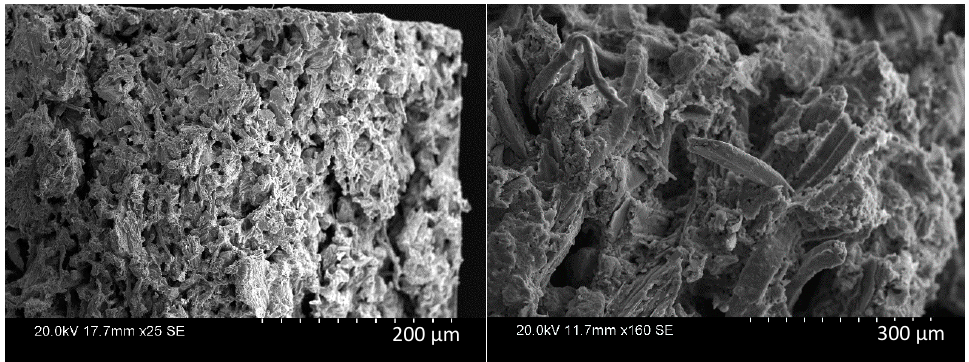
Figure 6. SEM Images of the sample having vertical failure showing random distribution of fibers in all the direction.